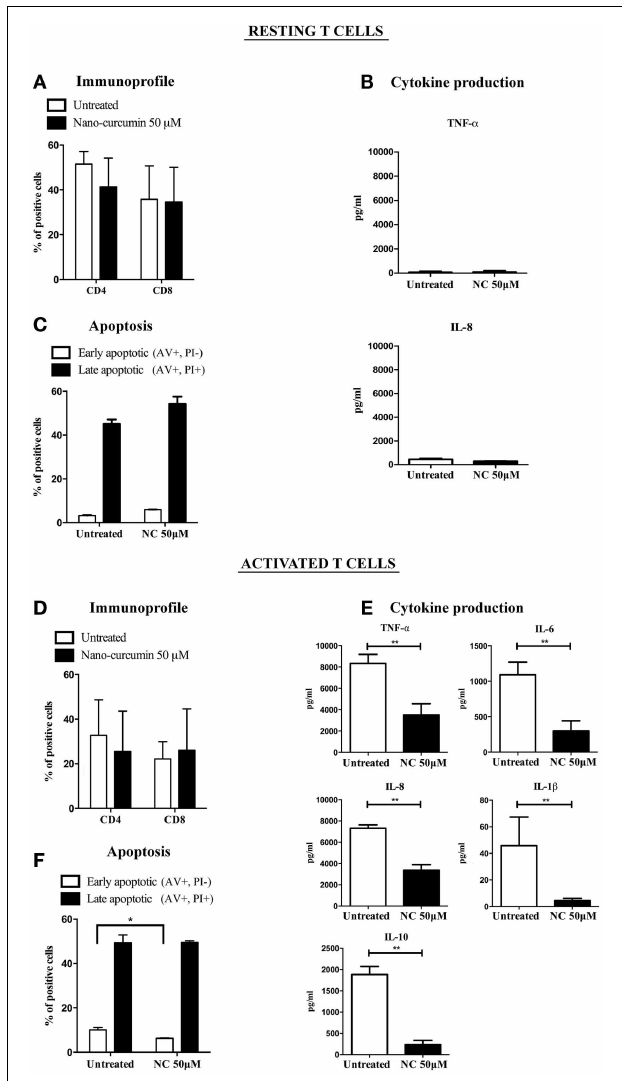
FIGURE 4 | Effect of nano-curcumin on resting and activatedT cells . (A) As measured by FACS, the CD4/CD8 ratio of restingT cells does not change after nano-curcumin treatment (student’s two tailed paired t test, P > 0,05, n = 3). (B) Nano-curcumin does not affect the release ofTNF- α and IL-8 of restingT cells (student’s two tailed paired t test, P > 0,05, n = 3). (C) The fractions of early apoptotic (annexinV + /PI − ) and late apoptotic/necrotic (annexinV + /PI + ) populations as measured by FACS analysis show no difference in apoptosis between restingT cells that were left untreated or treated with nano-curcumin (student’s two tailed paired t test, * P < 0.05, n = 3). (D) As measured by FACS, the CD4/CD8 ratio of activatedT cells does not change after nano-curcumin treatment (student’s two tailed paired t test, P > 0,05, n = 3). (E) Nano-curcumin reduces the production ofTNF- α , IL-8, IL-6, IL-10, IL-1 β in activatedT cells (student’s two tailed paired t test, ** P < 0.01, n = 3). (F) There is a decrease of the early apoptotic (AV + /PI − ) fraction of the activatedT cells after treatment with nano-curcumin (student’s two tailed paired t test, * P < 0.05, n =